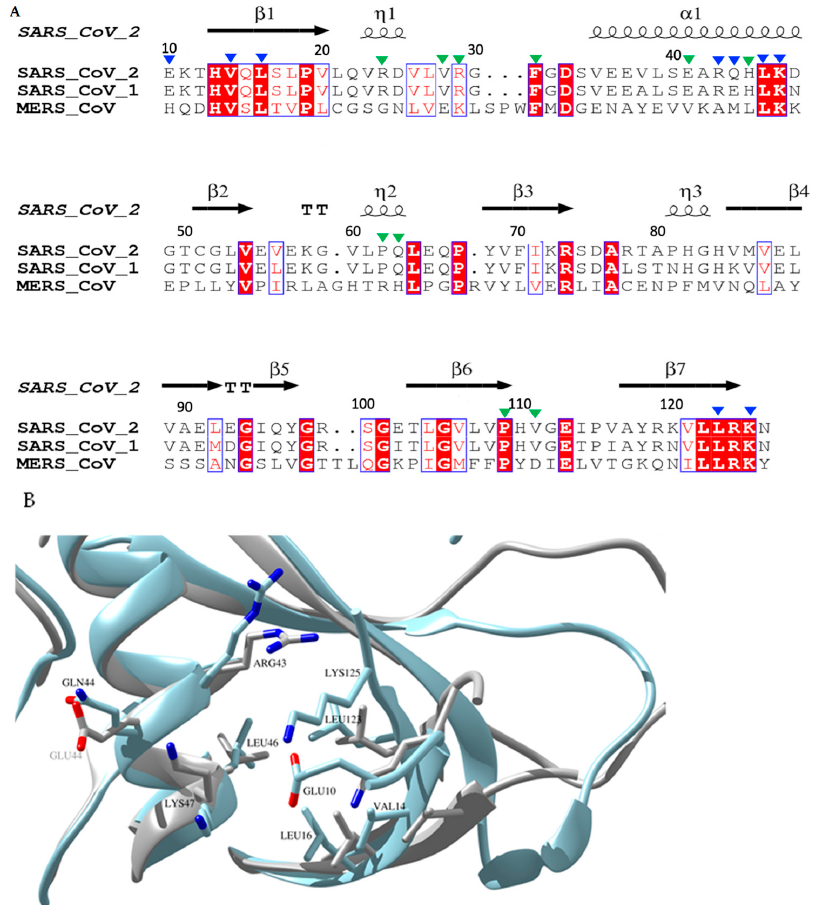
Figure 5. Sequence and structural alignment of the N ‐ terminal domain of three medically relevant coronaviruses SARS ‐ CoV ‐ 2, SARS ‐ CoV ‐ 1 and MERS nsp1s. ( A ) Structural protein sequence alignment of SARS ‐ CoV ‐ 1, SARS ‐ CoV ‐ 2 and MERS. Key residues in binding pockets I and II are indicated by blue and green triangles, respectively. The sequences were aligned using CLUSTAL W multiple alignment [43] and the secondary structure elements were extracted using ESPript 3.0 [44]. ( B ) Overlay of SARS ‐ CoV ‐ 1 (coloured in light grey) and SARS ‐ CoV ‐ 2 (coloured in light blue) highlighting the structural differences around binding pocket I (RMSD of 0.748 Å). Pairwise key residues of the two nsp1s in pocket I interacting with fragment hits are shown in sticks. Glu10 is absent in the NMR structure of SARS ‐ CoV ‐ 1 nsp1 (PDB entry 2HSX).